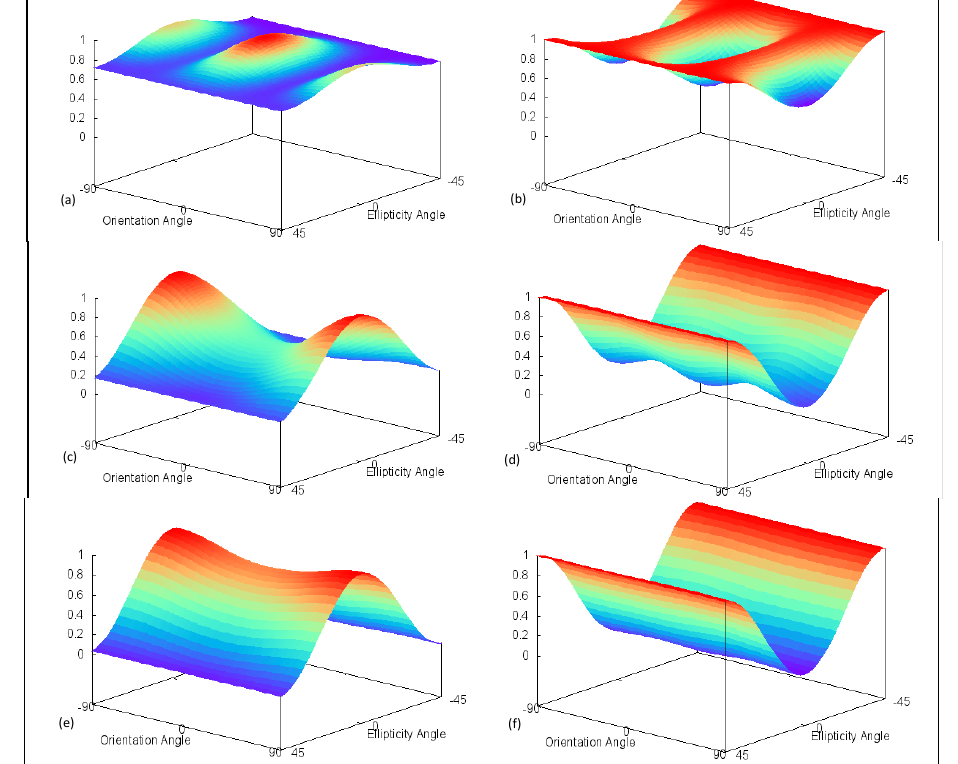
Figure 12. Surface water co- (Left) and cross-polarization (Right) polarimetric response plots based on RADARSAT-2 fine-quad beam modes for 20 June ( a , b ); 7 August ( c , d ); and 21 September ( e , f